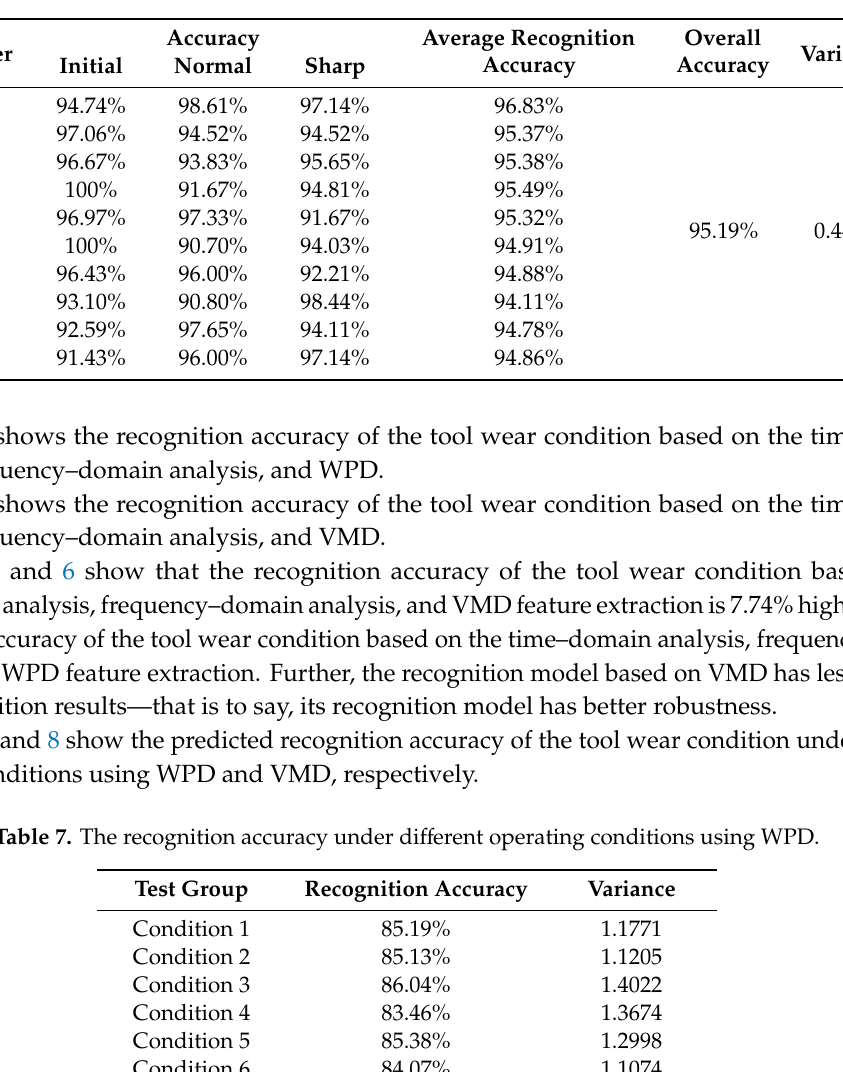
Table 6. The recognition accuracy of the tool wear condition based on the time–domain analysis, frequency–domain analysis, and variational mode decomposition (VMD).